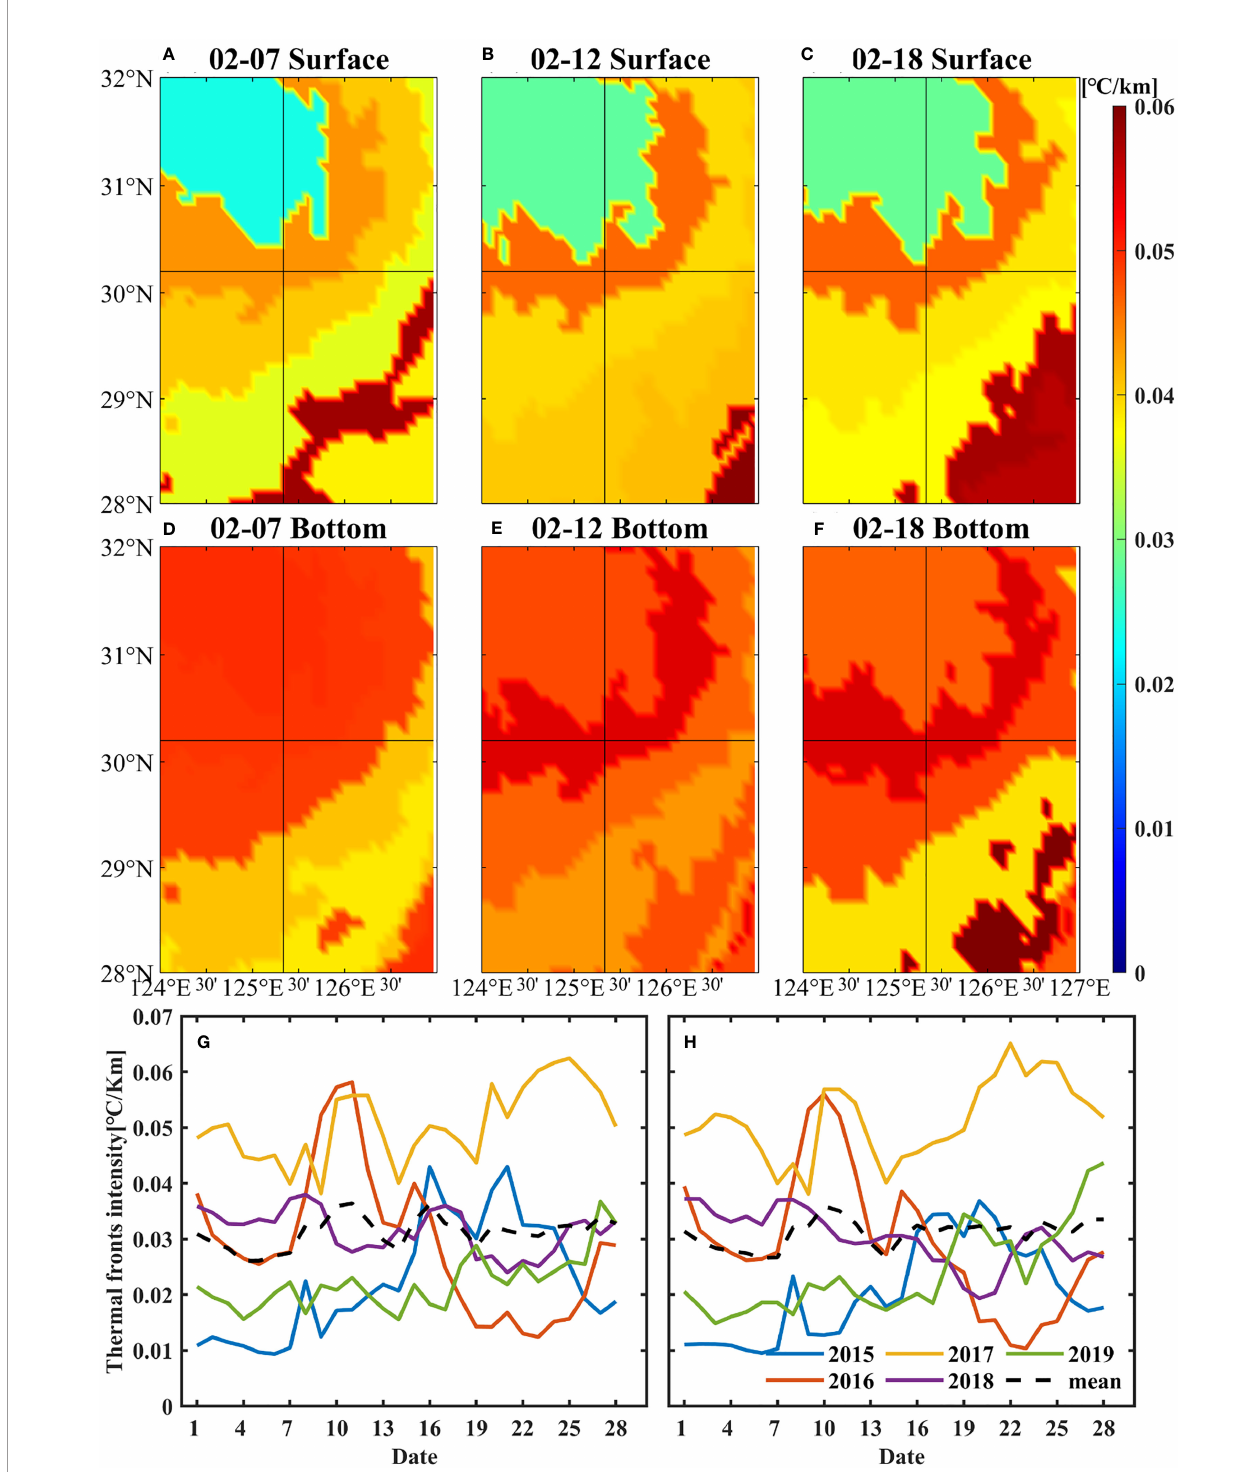
FIGURE 8 | Spatial distribution of surface (A – C) and bottom (D – F) thermal fronts near the target site in February 2017. The fronts had been averaged between two isotherms. Daily variations of thermal front intensity near the target site in February from 2015 to 2019 (G, H) , (G) refers to the surface and (H) refers to the bottom. The solid lines indicate the frontal intensity in 2015-2019, respectively, and black-dashed lines indicate the average front intensity in 2015-2019. The data were obtained from